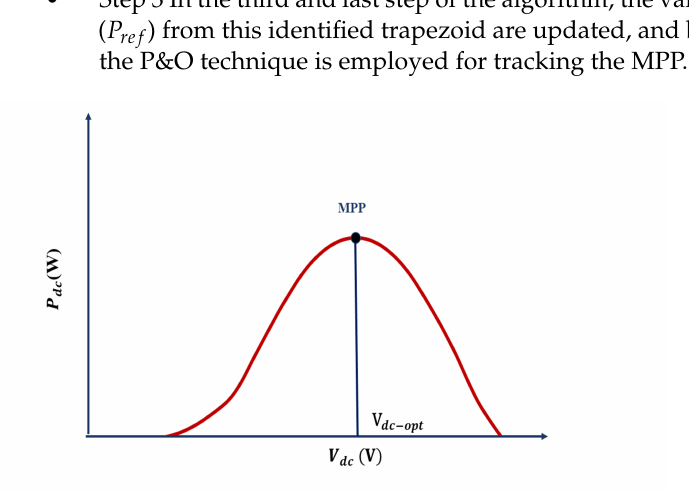
Figure 7. Relation between P dc and V dc .